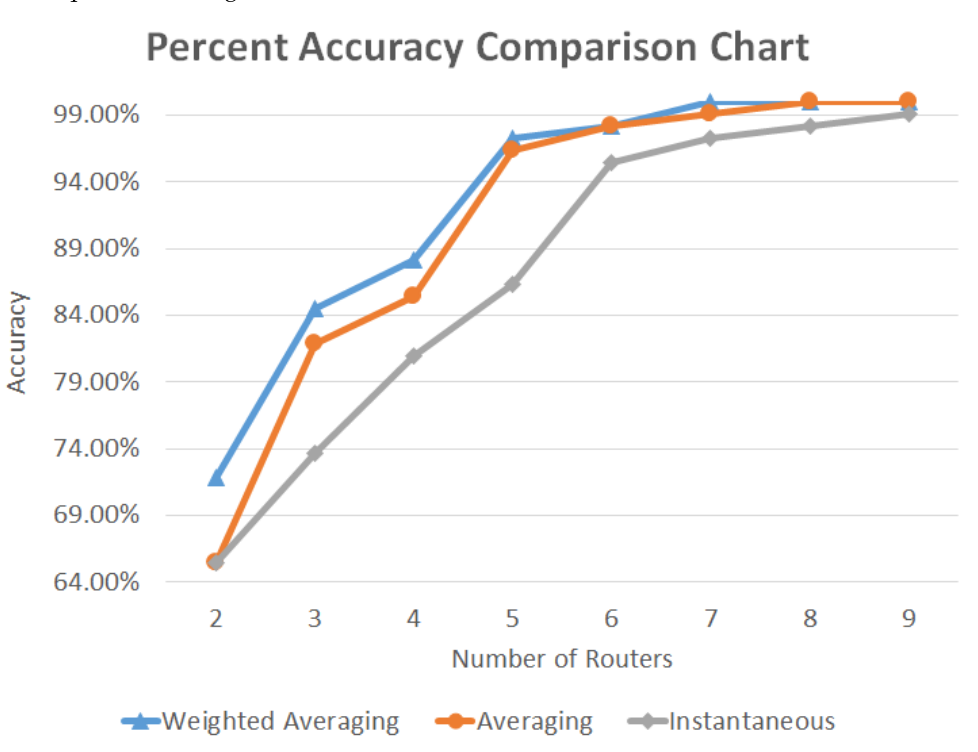
Figure 8. The prediction accuracy employing the three methods as the number of deployed routers is